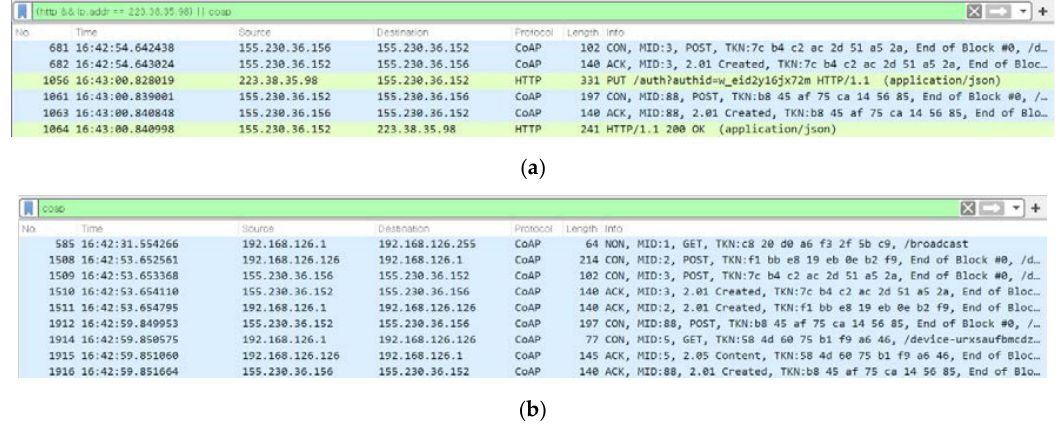
Figure 20. Packet capturing results for IVI device registration process: ( a ) Packet capture for IVI master, ( b ) Packet capture for IVI agent.